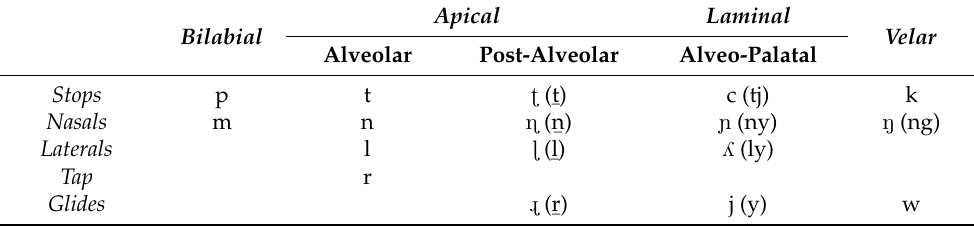
Table 1. Pitjantjatjara consonant inventory. Adapted from Tabain and Butcher (2014, p.